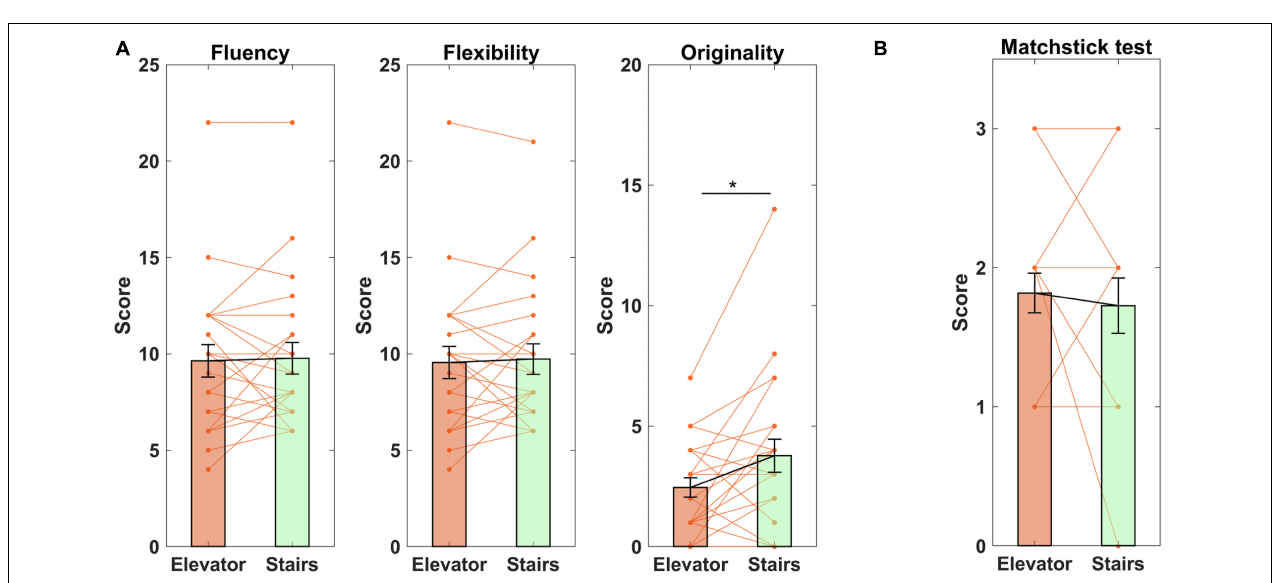
FIGURE 2 | Intervention effect on heart rate, time taken to return to the laboratory room, and mood. (A) Heart rate and time taken; (B) , mood. The data on different test days are combined and plotted together. *** p < 0.001 bpm, beat per minutes. VAS, visual analog scale. Data shown as mean ± SE.